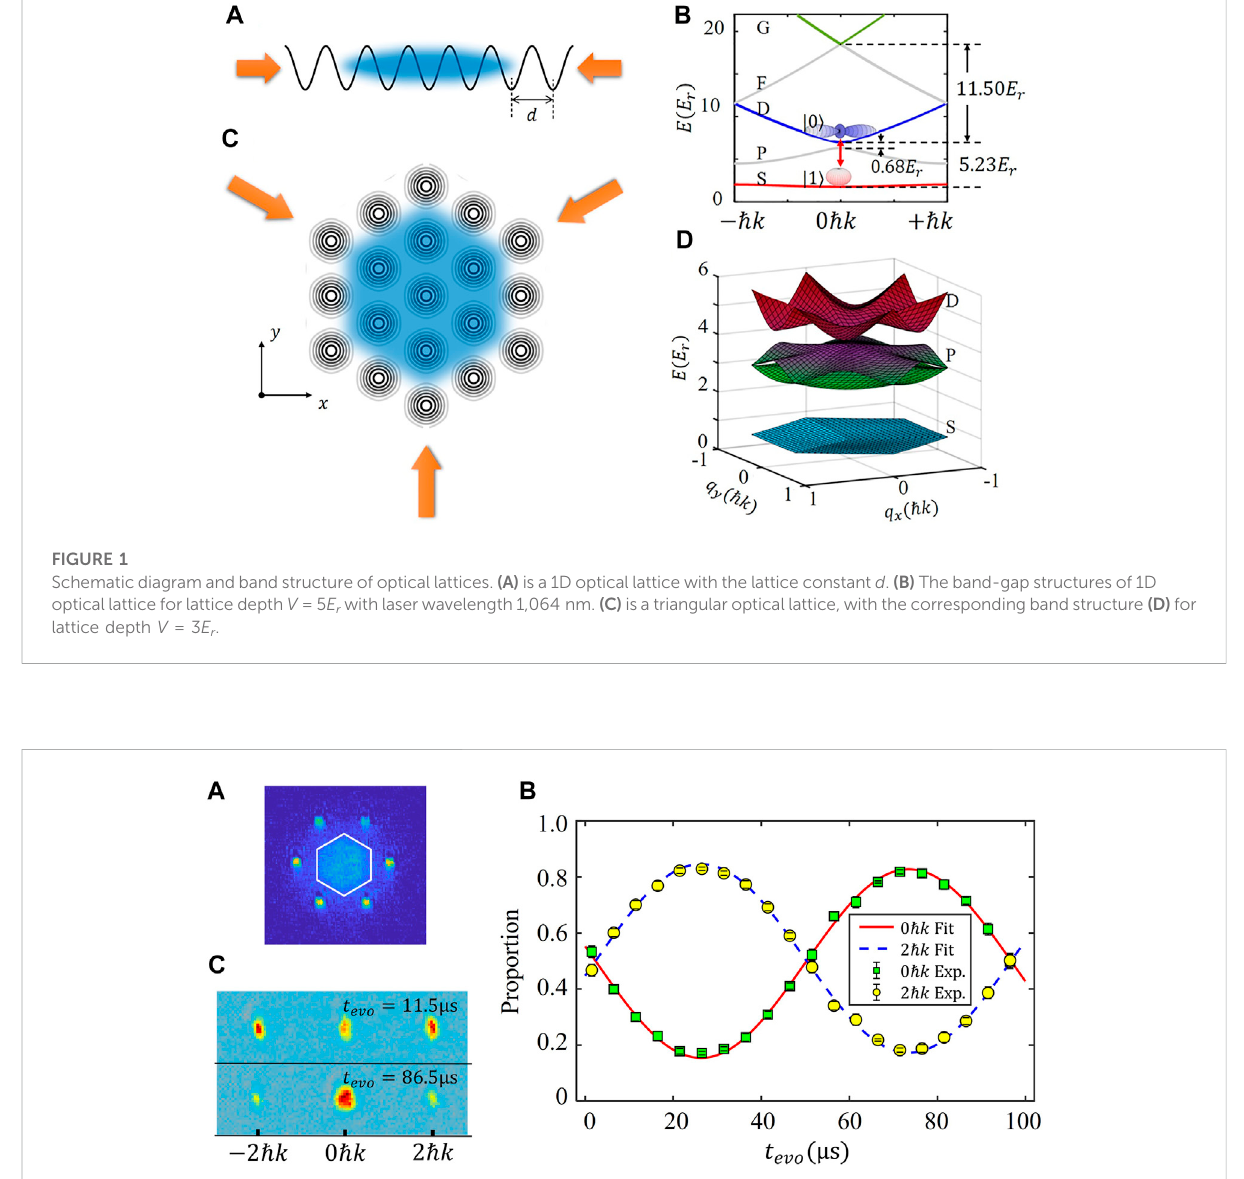
FIGURE 2 (A) Experimental result of atoms in D-band after band mapping process. The white hexagon is the boundary of the fi rst Brillouin zone of the triangular lattice. The atoms are mainly distributed in the fourth Brillouin zone. (B) TOF quantum state tomography process. The initial state is a superpositionBloch state of the1D opticallattice. After differentevolution time t evo , theatom number proportion at0 Z k and ± 2 Z k are shown bythe green and yellow points. (C) The momentum distribution of atoms at t evo = 11.5 μ s and 86.5 μ s. The lattice depth is V = 5 E r